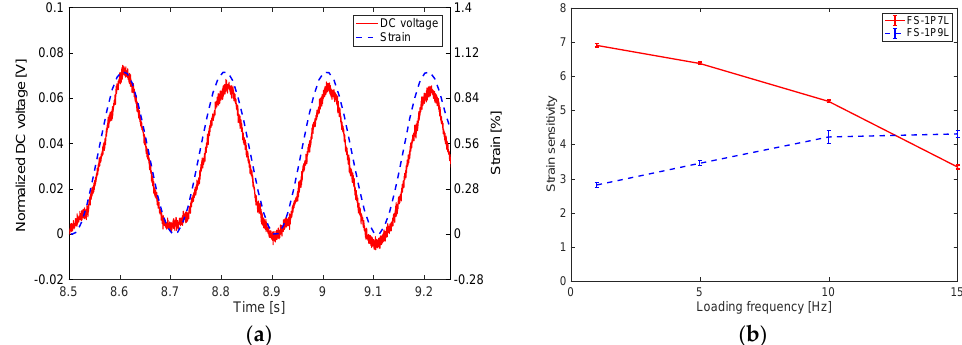
Figure 14. ( a ) DC voltage generated from FS 1P7L sensor varies with applied sinusoidal tensile loading and unloading cycles. ( b ) Strain sensitivities of the flexible sensor specimens are shown with loading frequencies.